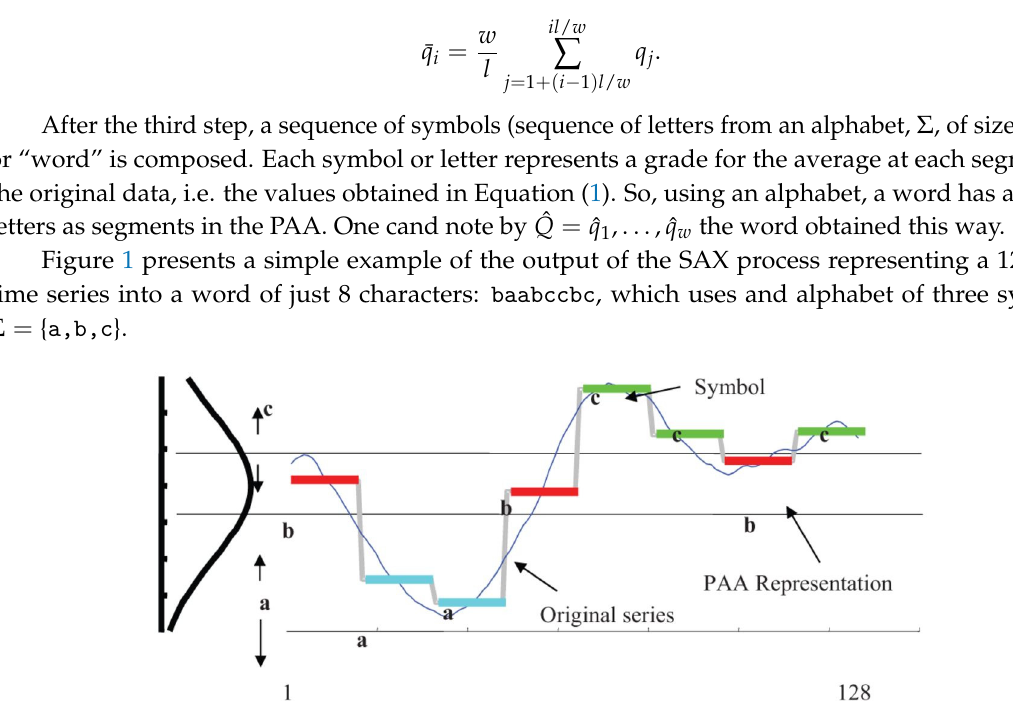
Figure 1. SAX representation of a series adapted from